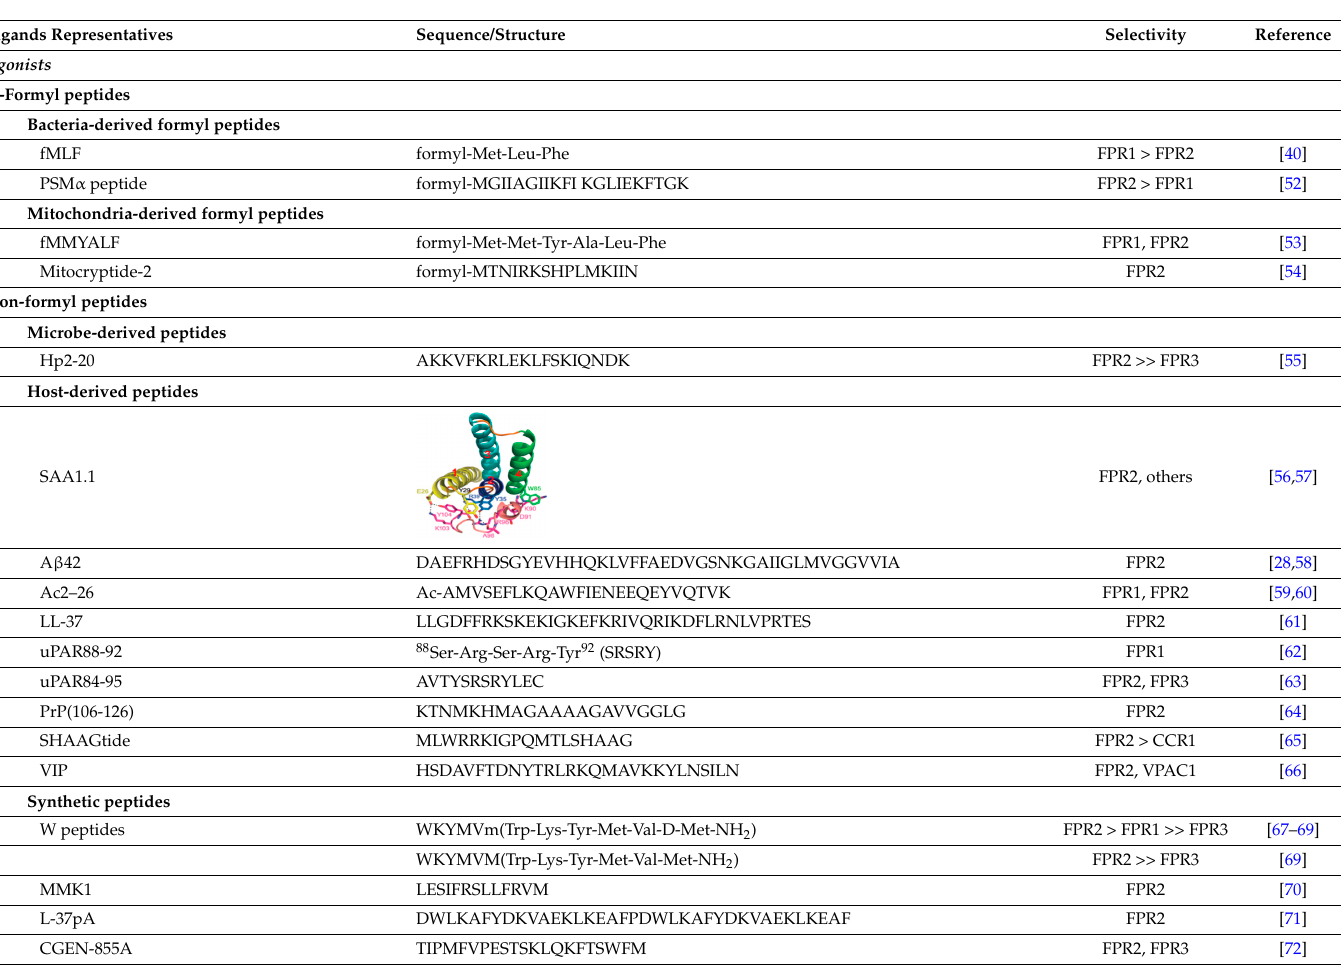
Table 1. Structures and sequences of representative FPR ligands. The table shows selected FPR ligands in different categories, based on their origins and chemical structures. Ac = acetyl; Me = methyl; Ph = phenyl; Pam = palmitoyl; N.D, binding affinity or potency not determined.